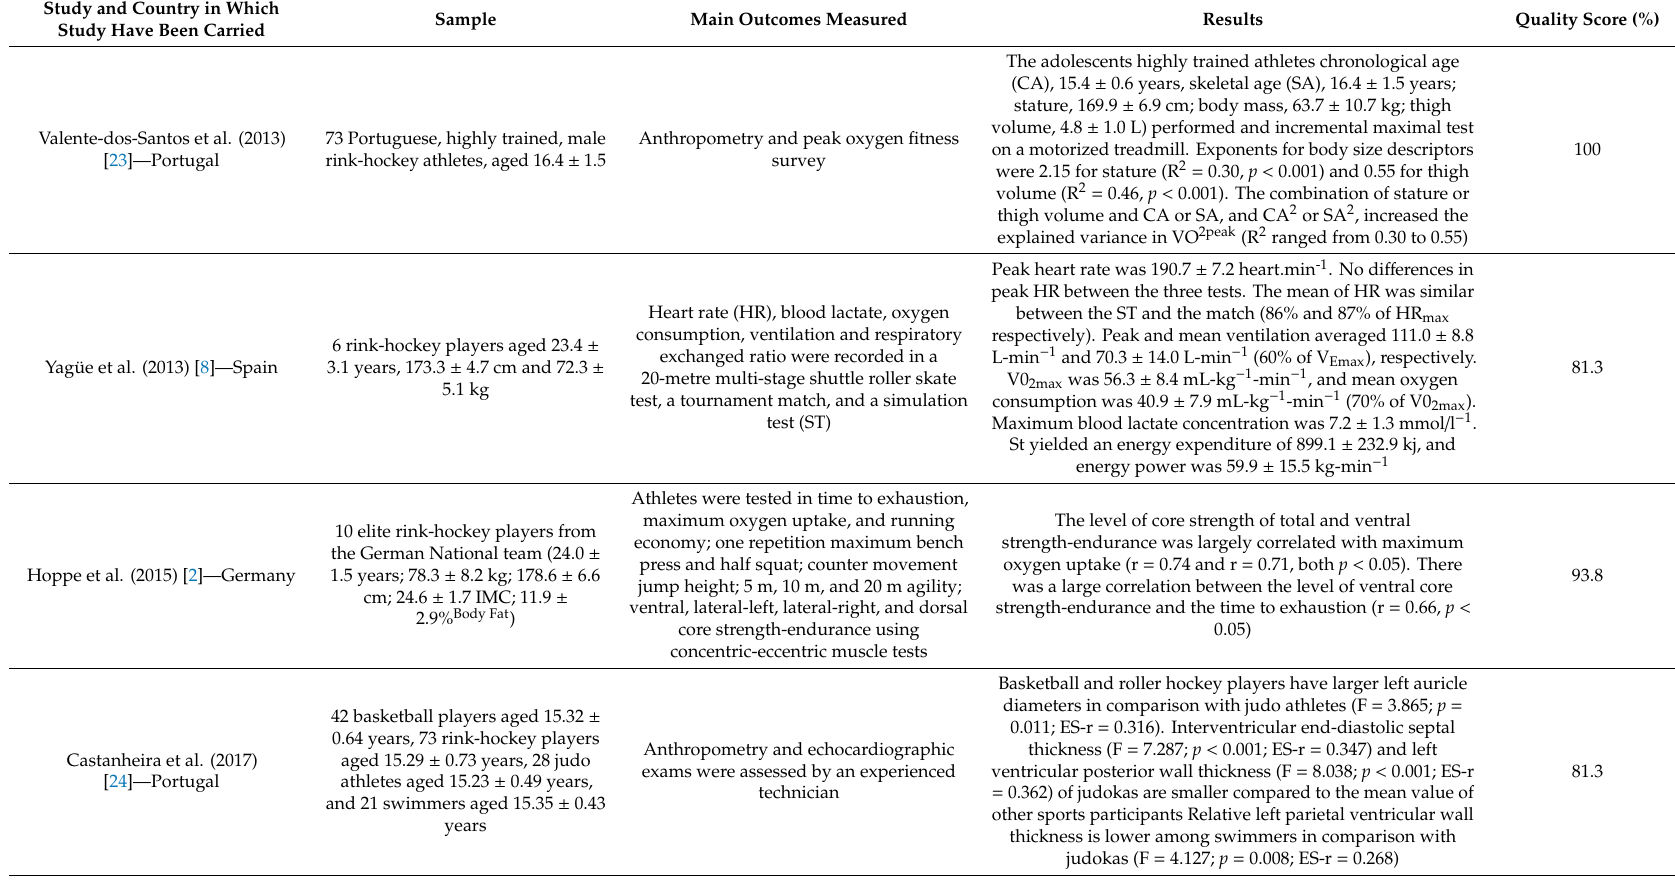
Table 1. Articles predominantly related to physiological demands in